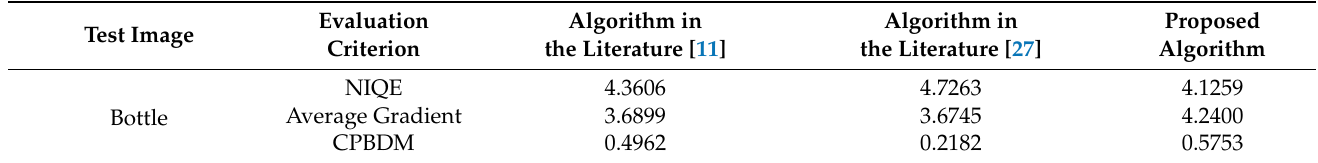
Table 9. Final results of the no. 2